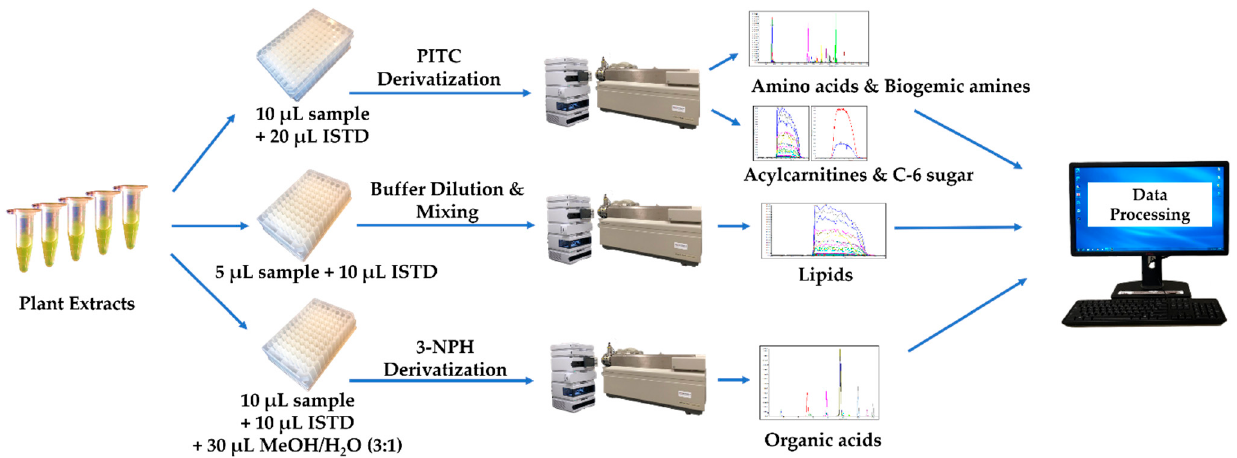
Figure 2. Schematic description of the plant extract analysis process.